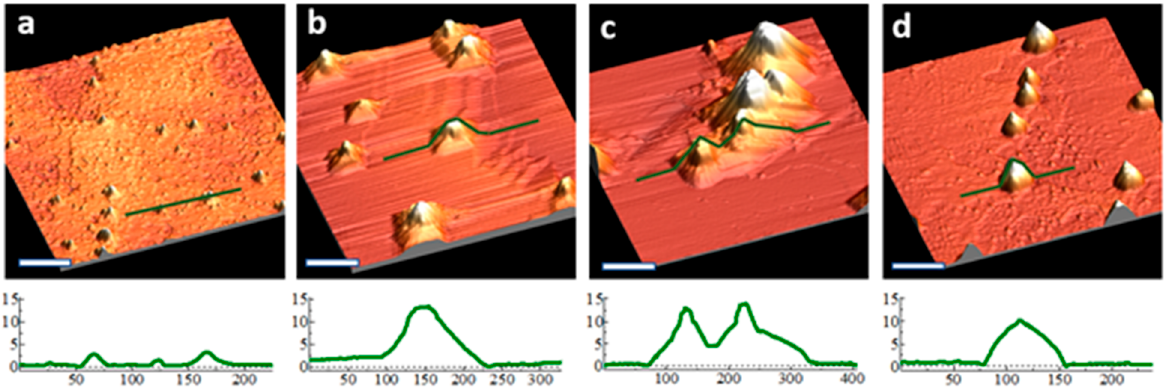
Figure 6. STM 3D images of a bare Ge (110) sample with cleaning cycles performed in a Ag-coated sample holder using ( a ) 100 eV Ar+, 33 cleaning cycles, fluence 3.7 × 10 17 cm − 2 ; ( b ) 200 eV Ar+, 40 cleaning cycles, fluence 7.9 × 10 17 cm − 2 ; ( c ) 400 eV Ar+, 32 cleaning cycles, fluence 1.2 × 10 18 cm − 2 ; and ( d ) 500 eV Ar+, 38 cleaning cycles fluence 1.7 × 10 18 cm − 2 . Profiles below each image, with units in nm, are taken along the lines shown in the image. Imaging parameters 0.5 nA, 2 V tip bias. Scale bars: 120 nm.